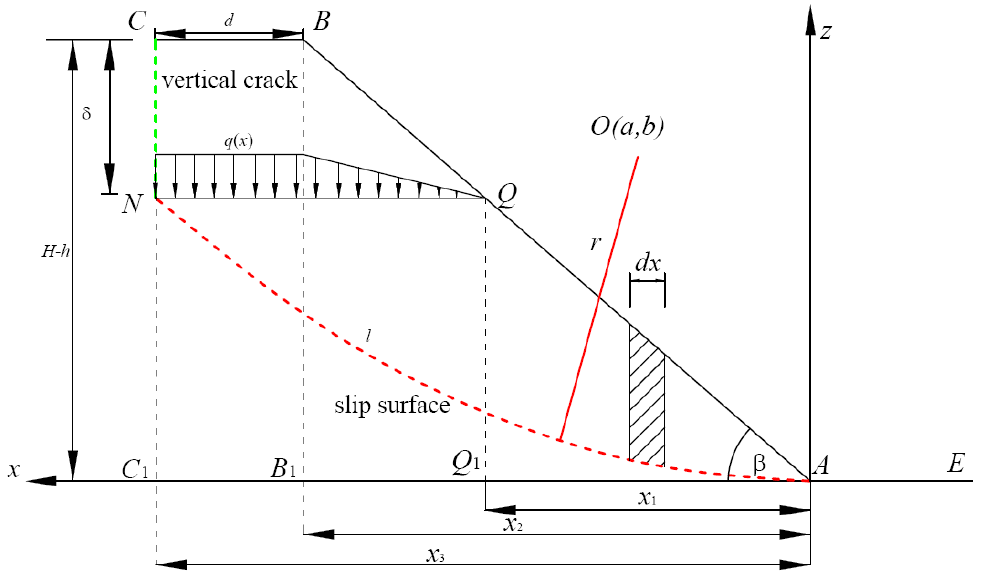
Figure 6. Face circle slope calculated model.